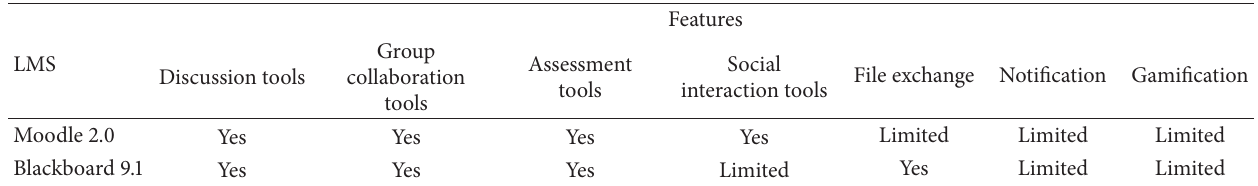
Table 1: Comparisons between 2 popular LMSs available within the